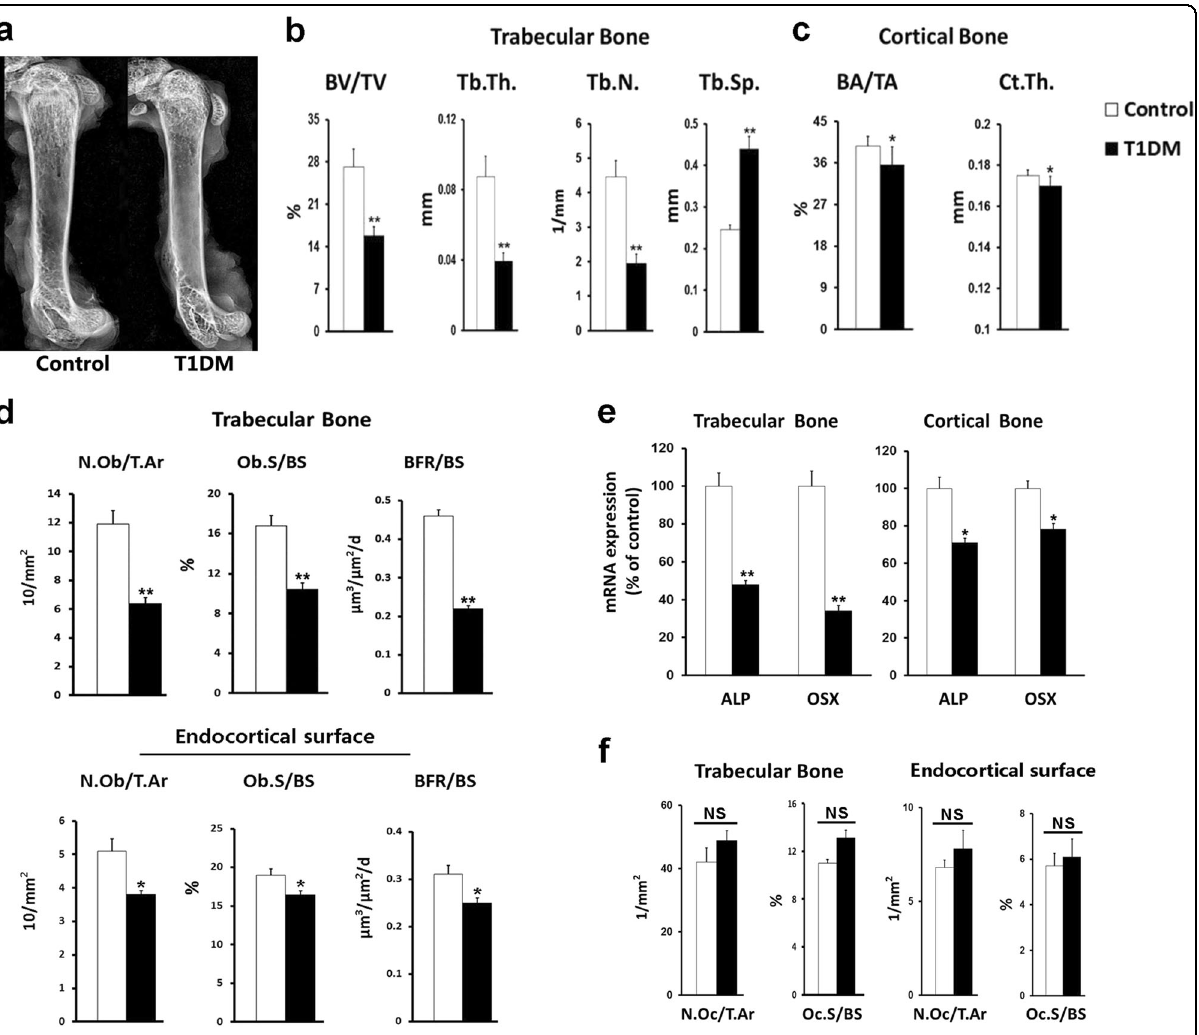
thickness (Tb.Th.), trabecular number (Tb.N.), trabecular separation (Tb.Sp.), cortical bone area per tissue area (BA/TA), and cortical thickness (CT.Th.), as measured by micro-CT. n = 9/control, 7/T1DM. d Static and dynamic histomorphometric analyses were performed in the trabecular bone and endocortical surface of the femur. N.Ob/T.Ar osteoblast number per tissue area, Ob.S/BS osteoblast surface per bone surface, BFR/BS bone formation rate per bone surface. n = 9. e mRNA expression levels of osteoblast markers in trabecular and cortical bone. ALP alkaline phosphatase, OSX osterix. n = 8. f Histomorphometric quanti fi cation of TRAP-stained osteoclasts in the trabecular bone and endocortical surface of the femur. n = 9. N.Oc/T.Ar osteoclast number normalized to tissue area, Oc.S/BS osteoclast surface normalized to bone surface. Data are expressed as the mean ± SD. * P < 0.05, ** P < 0.01 versus Control group by an unpaired t -test. NS not signi fi cant, P >